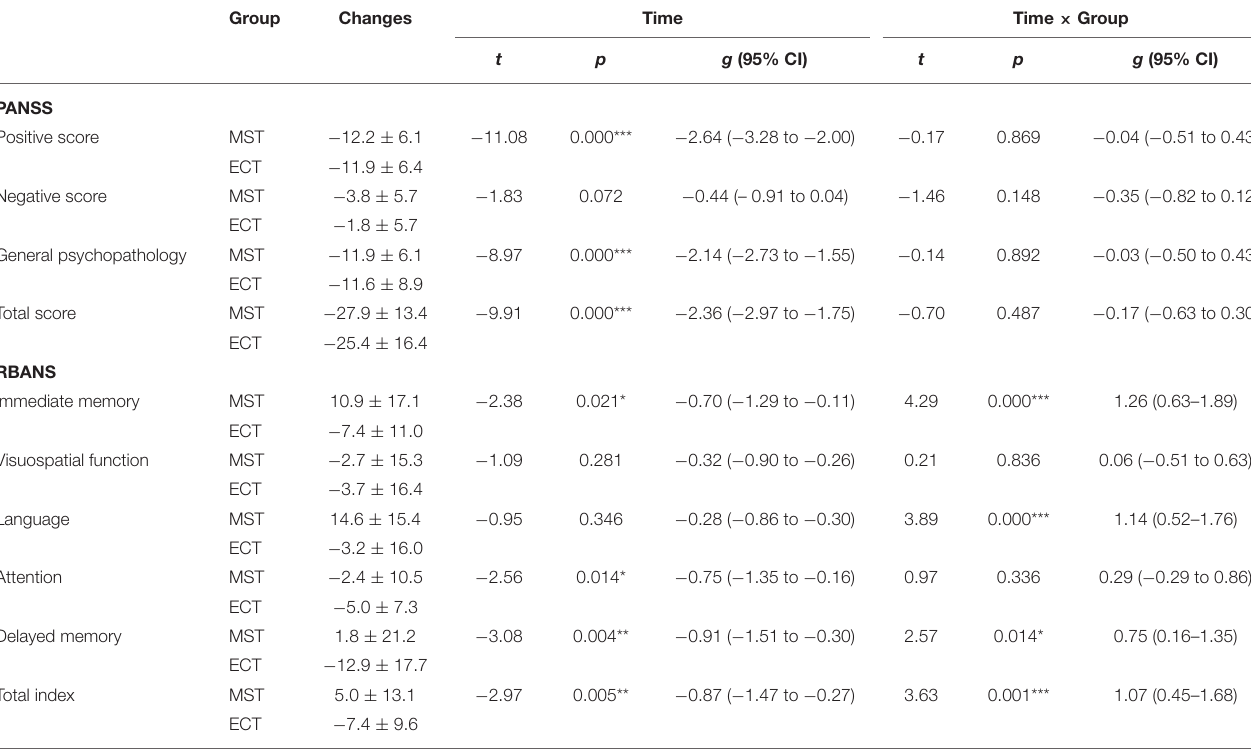
TABLE 3 | The effects of MST and ECT on psychotic symptoms and cognitive functions in the per protocol